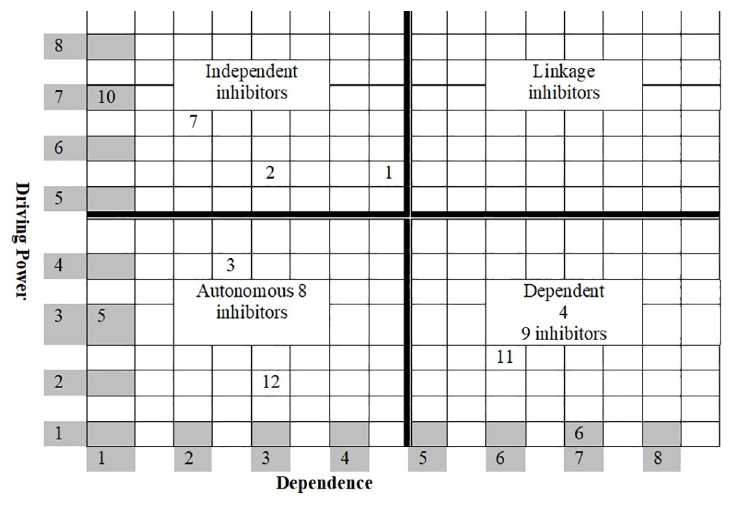
Fig 4. Driving power and dependence diagram